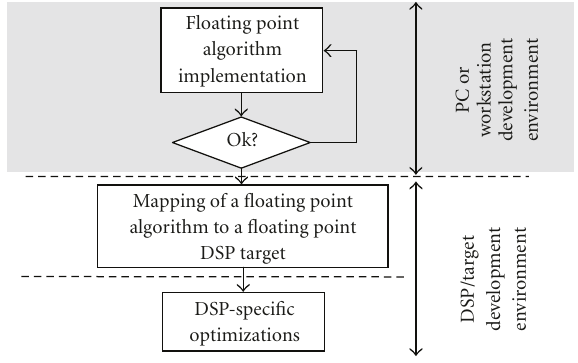
Figure 3: Floating point design